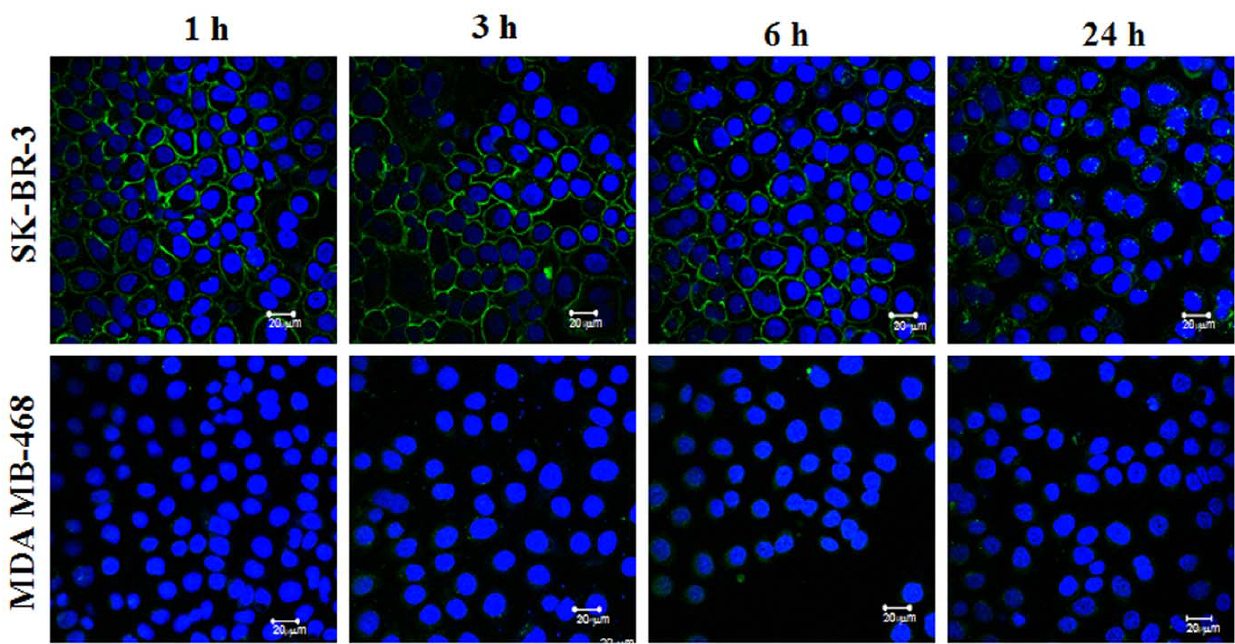
Figure 3. Confocal microscopy of HER2-positive (upper panel) and HER2-negative (lower panel) cells exposed to ZHER2-DyLight- 488. SK-BR-3 and MDA-MB-468 cells were plated at 2 6 10 4 cells/chamber and exposed to Z HER2 -DyLight-488 at 0.5 m g/ml. After a 30 min loading step, cells were rinsed and incubation was continued for indicated period of time at 37 u C. A half hour before imaging, the nuclei were counterstained with Hoechst 33342 at 0.2 m g/ml. Images were acquired using Zeiss LSM 510